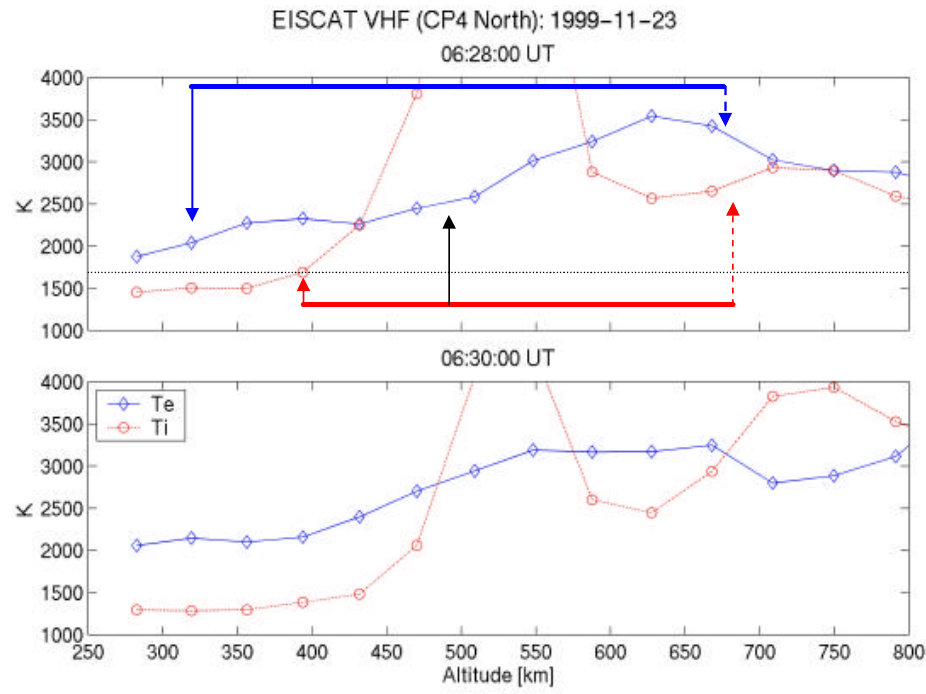
Fig. 4. The T e (red curve) and T i (blue curve) versus altitude along Beam 1 for data integration periods commencing at 06:28 and 06:30UT. The blue and the red bars are corresponding to Fig. 3 and mark out the regions of magnetosheath electron precipitation and the plasma flow channel measured by DMSP F13. The flow reversal boundary is indicated by the black arrow. The horizontal dashed line is a guideline for the T i =1700K